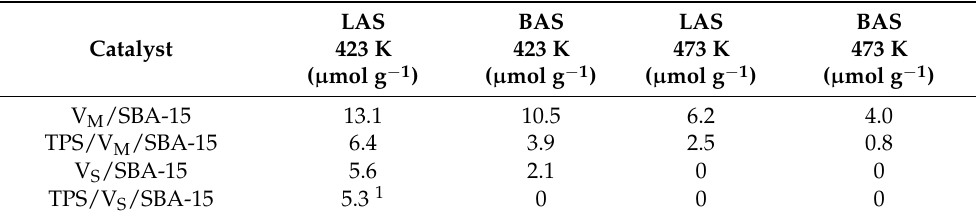
Figure 6. FTIR spectra recorded at room temperature after adsorption of pyridine at 423 K followed by desorption at 423 K for 0.5 h: ( a ) V M /SBA-15; ( b ) TPS/V M /SBA-15; ( c ) V S /SBA-15; ( d ) TPS/V S /SBA-15. Table 2. Number of Lewis (LAS) and Brønsted(BAS) acidic centers determined from the amount of pyridine remaining adsorbed after outgassing the samples at 423 and 473